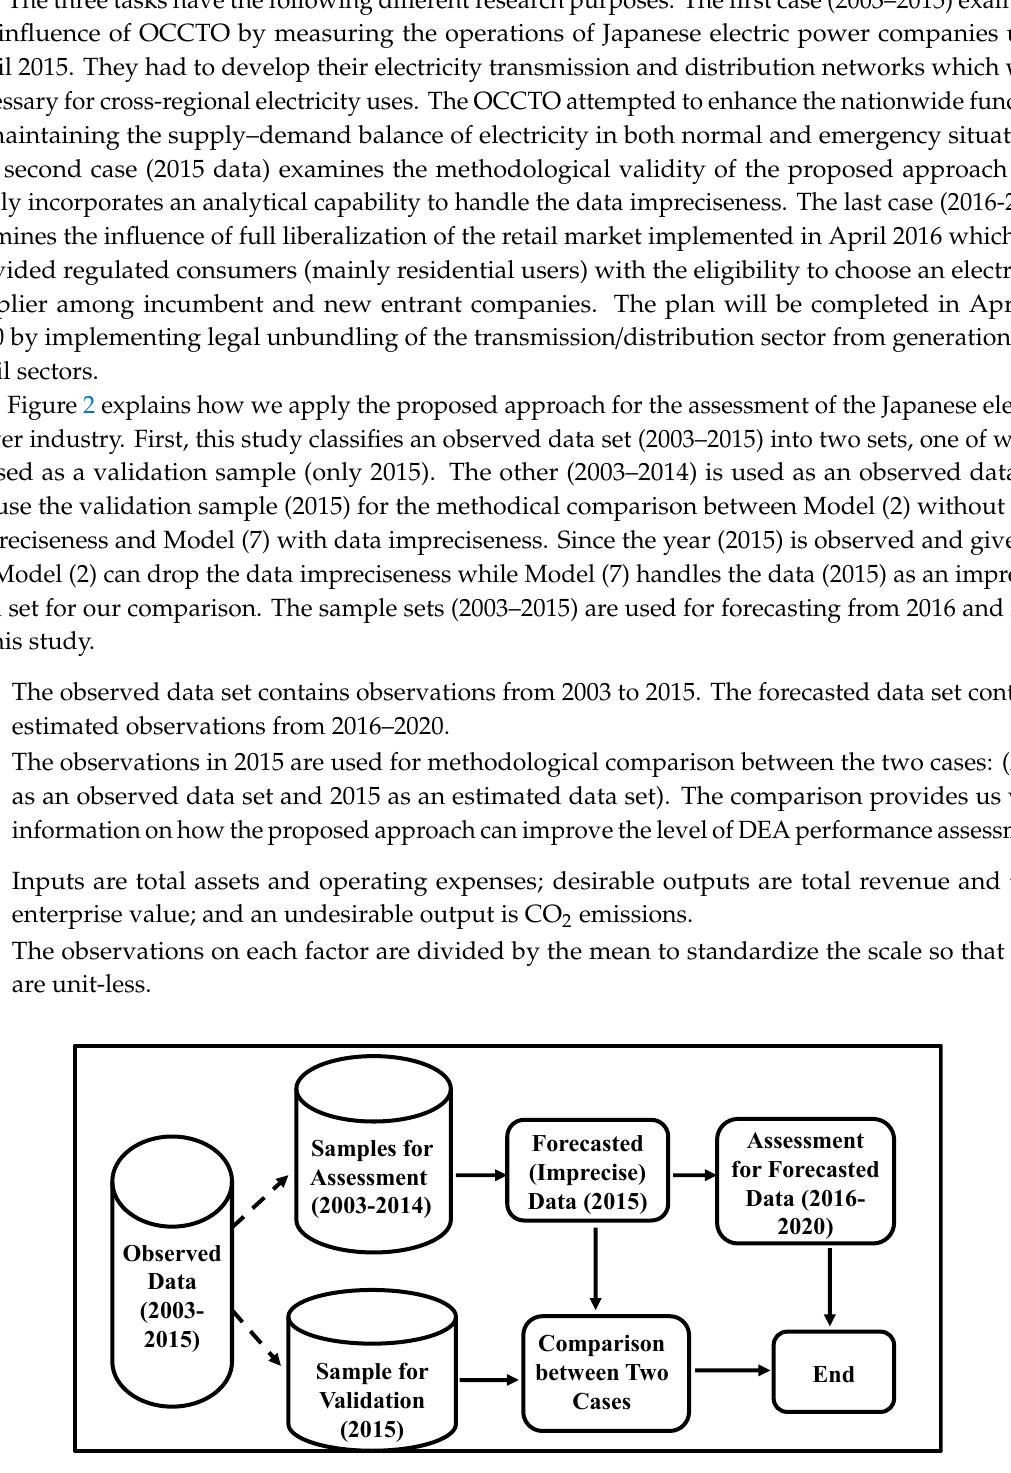
Figure 2. Methodological comparison and forecasting.